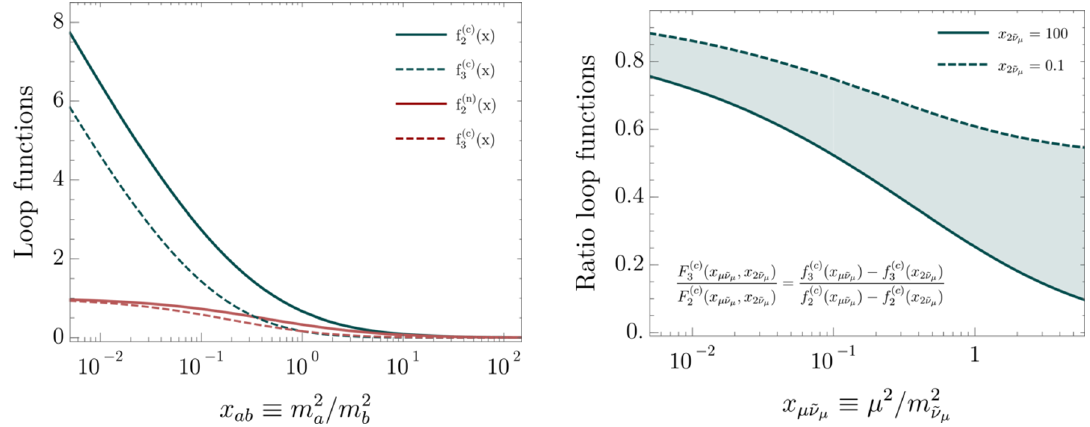
(solid line) and BR( (cid:22) ! e) (dashed) corresponding to (cid:22)